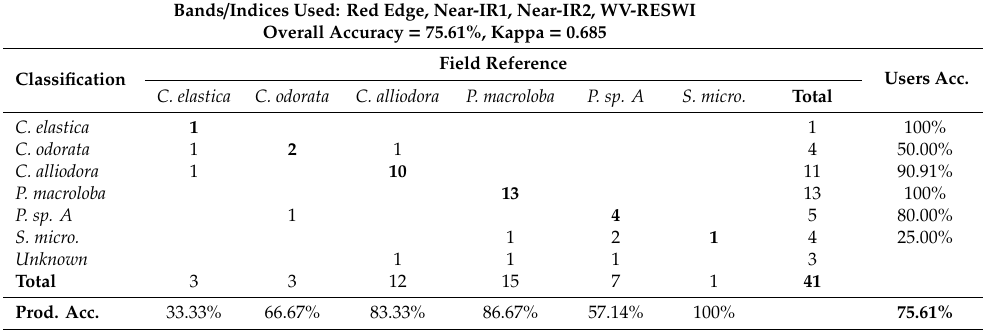
Prod. Acc. Table 7. Error Matrix—Classification 2. The classification results for all rule-sets specified by tree species. The abbreviation S. micro. represents the tree species S. microstachyum .